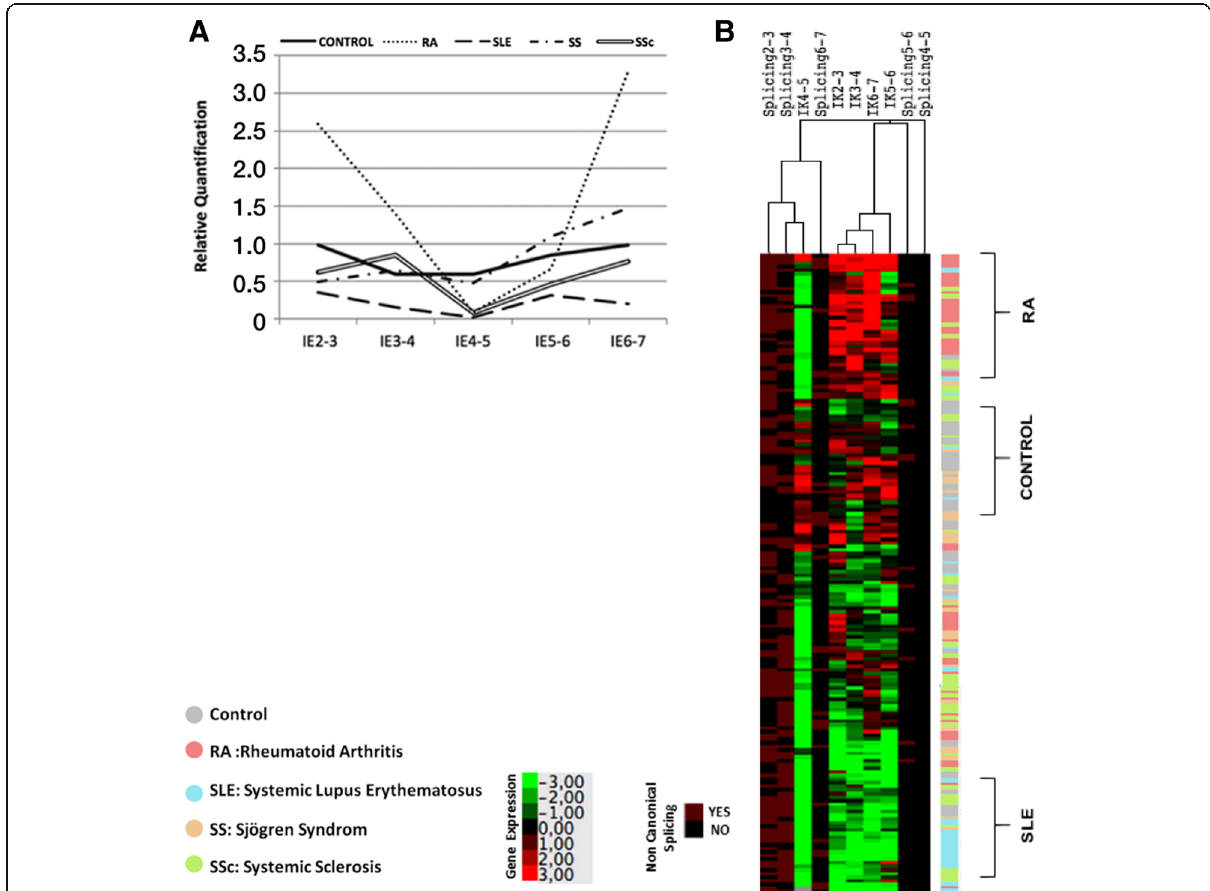
Fig. 4 Expression pattern and Hierarchical clustering of Ikaros in the assessed pathologies. ( a ) Expression pattern of Ikaros in the assessed pathologies: RA, rheumatoid arthritis; SSc, systemic sclerosis; SLE, systemic lupus erythaematosus; SS, Sjögren ’ s syndrome. ( b ) Hierarchical clustering of Ikaros differential expression. Rows represent cases of RA, SLE, SS, SSc and controls, and columns refer to the log 2 relative expression data and the absence or presence of non-canonical splicing. The expression levels are represented using a colour code with red and green corresponding to high and low expression, respectively, and the intensity refers to the magnitude of the deviation from the mean. The presence of non-canonical splicing is represented as “ YES ” and its absence as “ NO